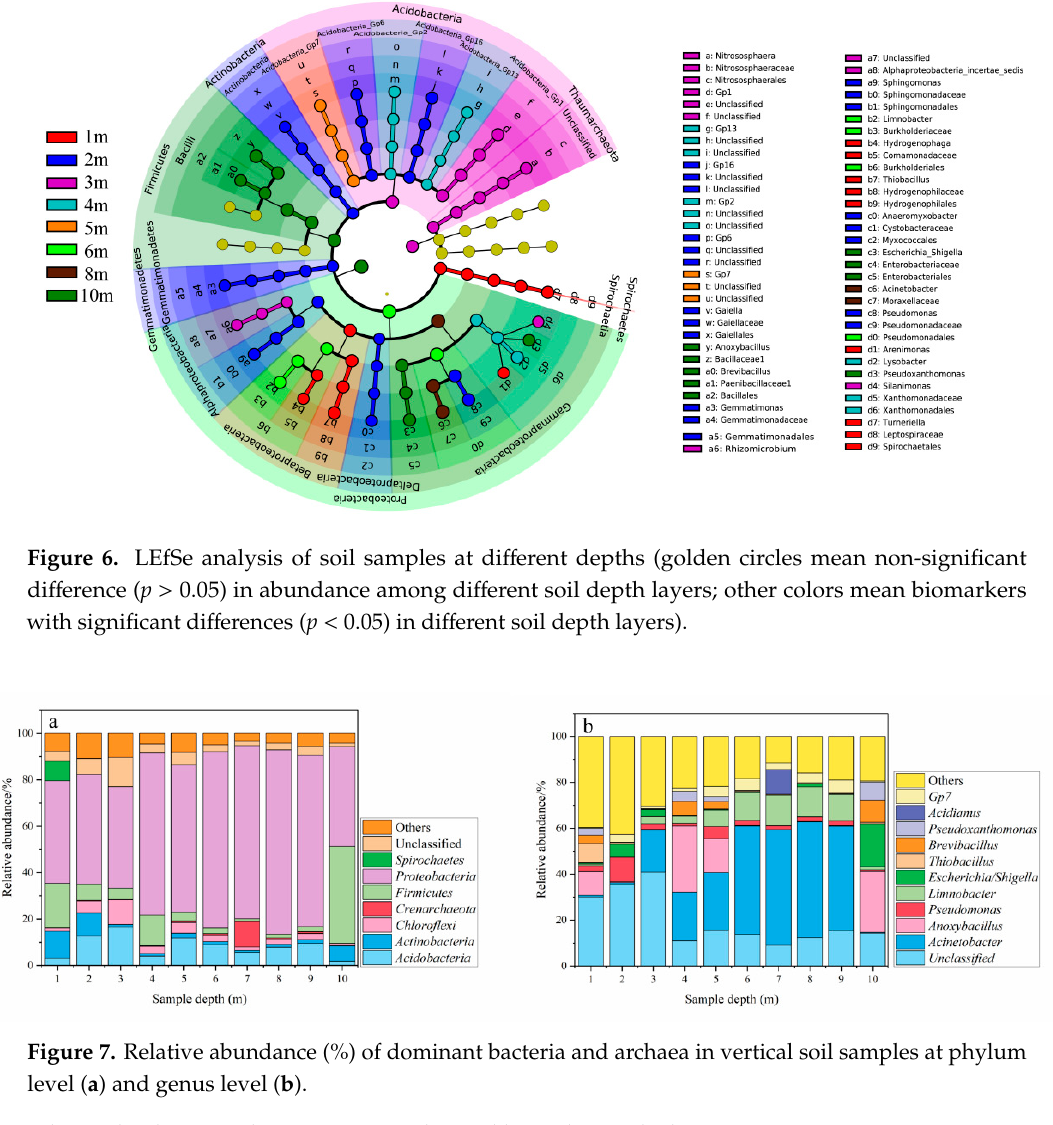
Figure 5. Venn diagram ( a ), Analysis of Similarities (ANOSIM) ( b ), Non-metric Multidimensional Scaling (NMDS) ( c ), and Detrended Correspondence Analysis (DCA) ( d ) analysis in OUT among ten depth layers of soil.